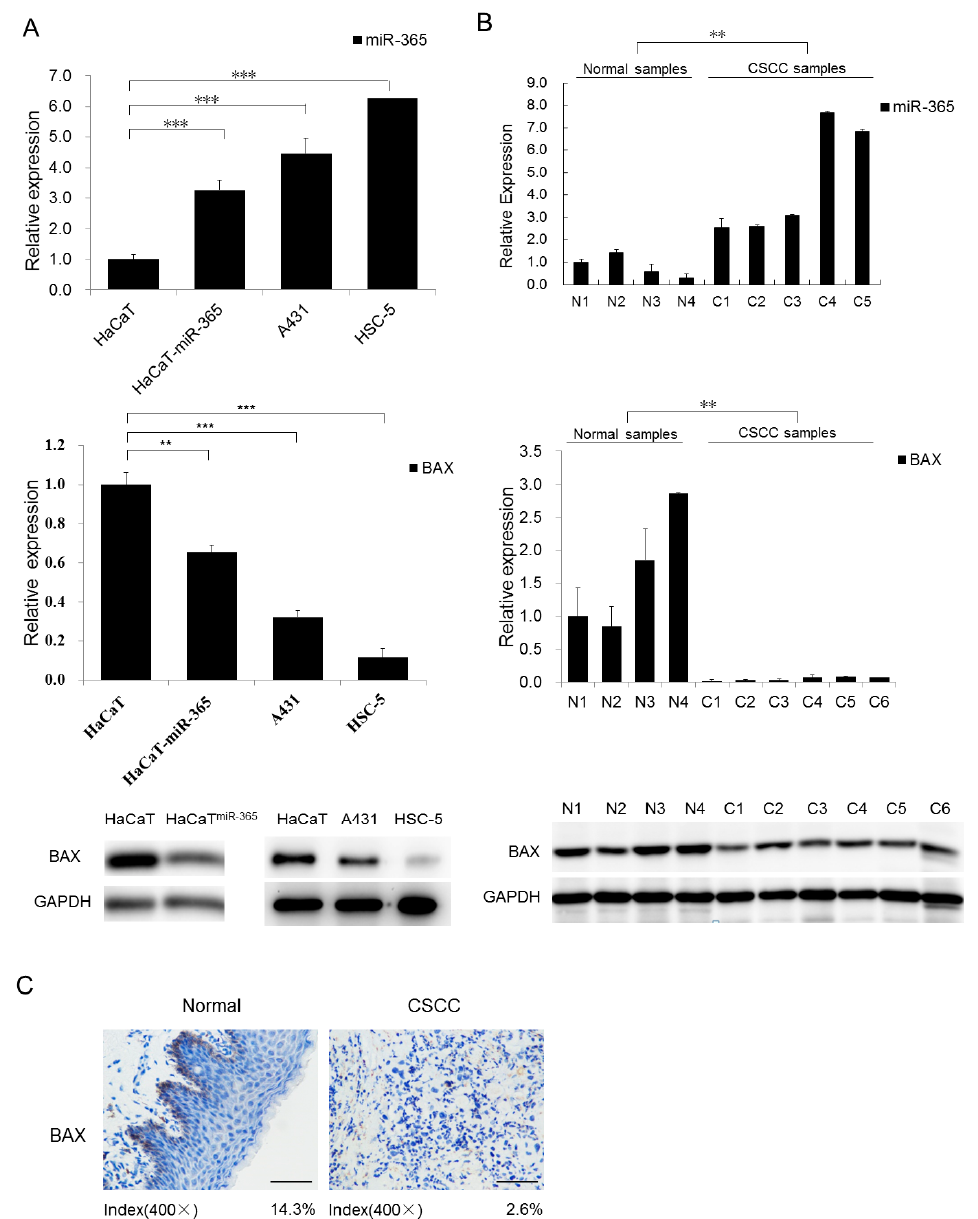
Figure 1. BAX is decreased in cutaneous squamous cell carcinoma (CSCC) primary tumors and cell lines. ( A ) BAX and miR-365 expression was detected in the CSCC cell lines A431, HSC-5, and HaCaT miR-365 compared with HaCaT keratinocytes in both mRNA and protein levels. The qPCR results were evaluated by normalizing to U6 snRNA (for miR-365) or GAPDH (for BAX). In Western blot, GAPDH was detected for using as loading control; ( B ) BAX and miR-365 expression were detected in normal tissues (N1–N4) and CSCC primary tumors (C1–C6) in both mRNA and protein levels; ( C ) IHC detection of BAX on paraffin sections of CSCC tumors and normal skin specimens. Positive signals were shown in brown staining (magnification, 400 × ), scale bars, 50 µ m. The percentage of positive staining was marked for each group. ** p < 0.01, *** p < 0.001.